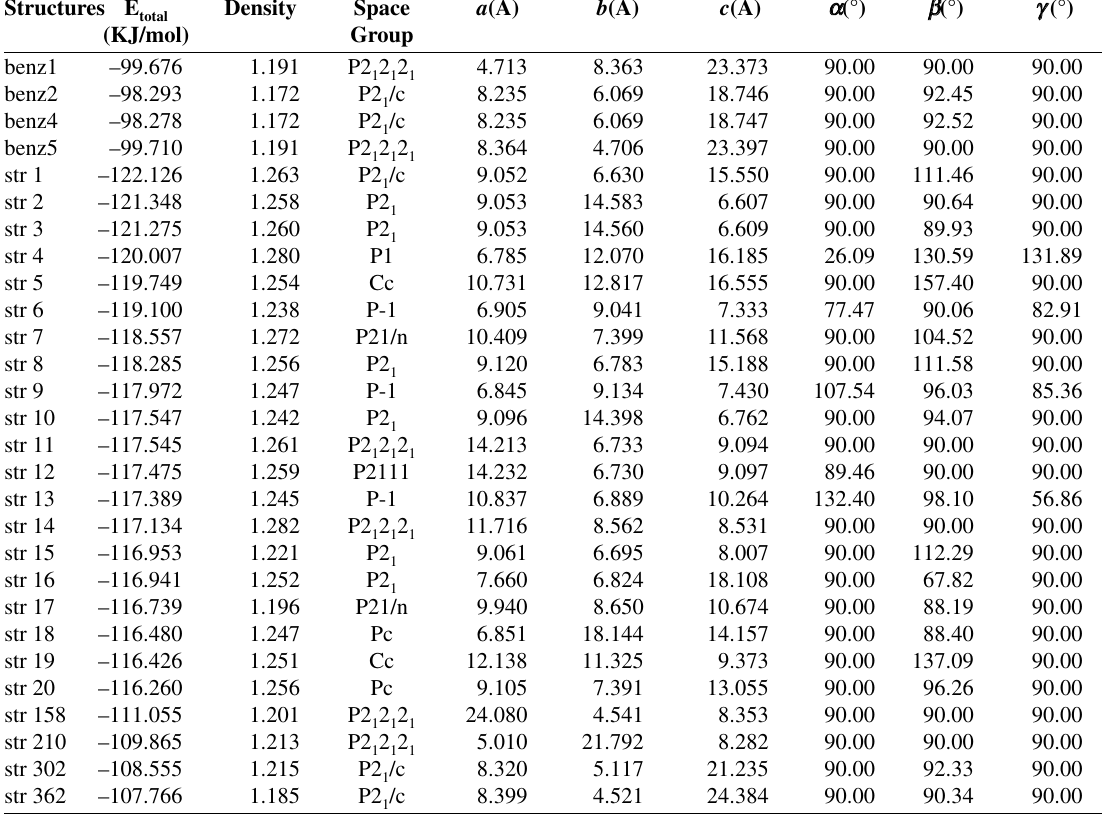
Table 1. List of Lowest energy conformers of benzocaine with the reproduced experimentally observed polymorphs of Benzocaine. Structures E Density total